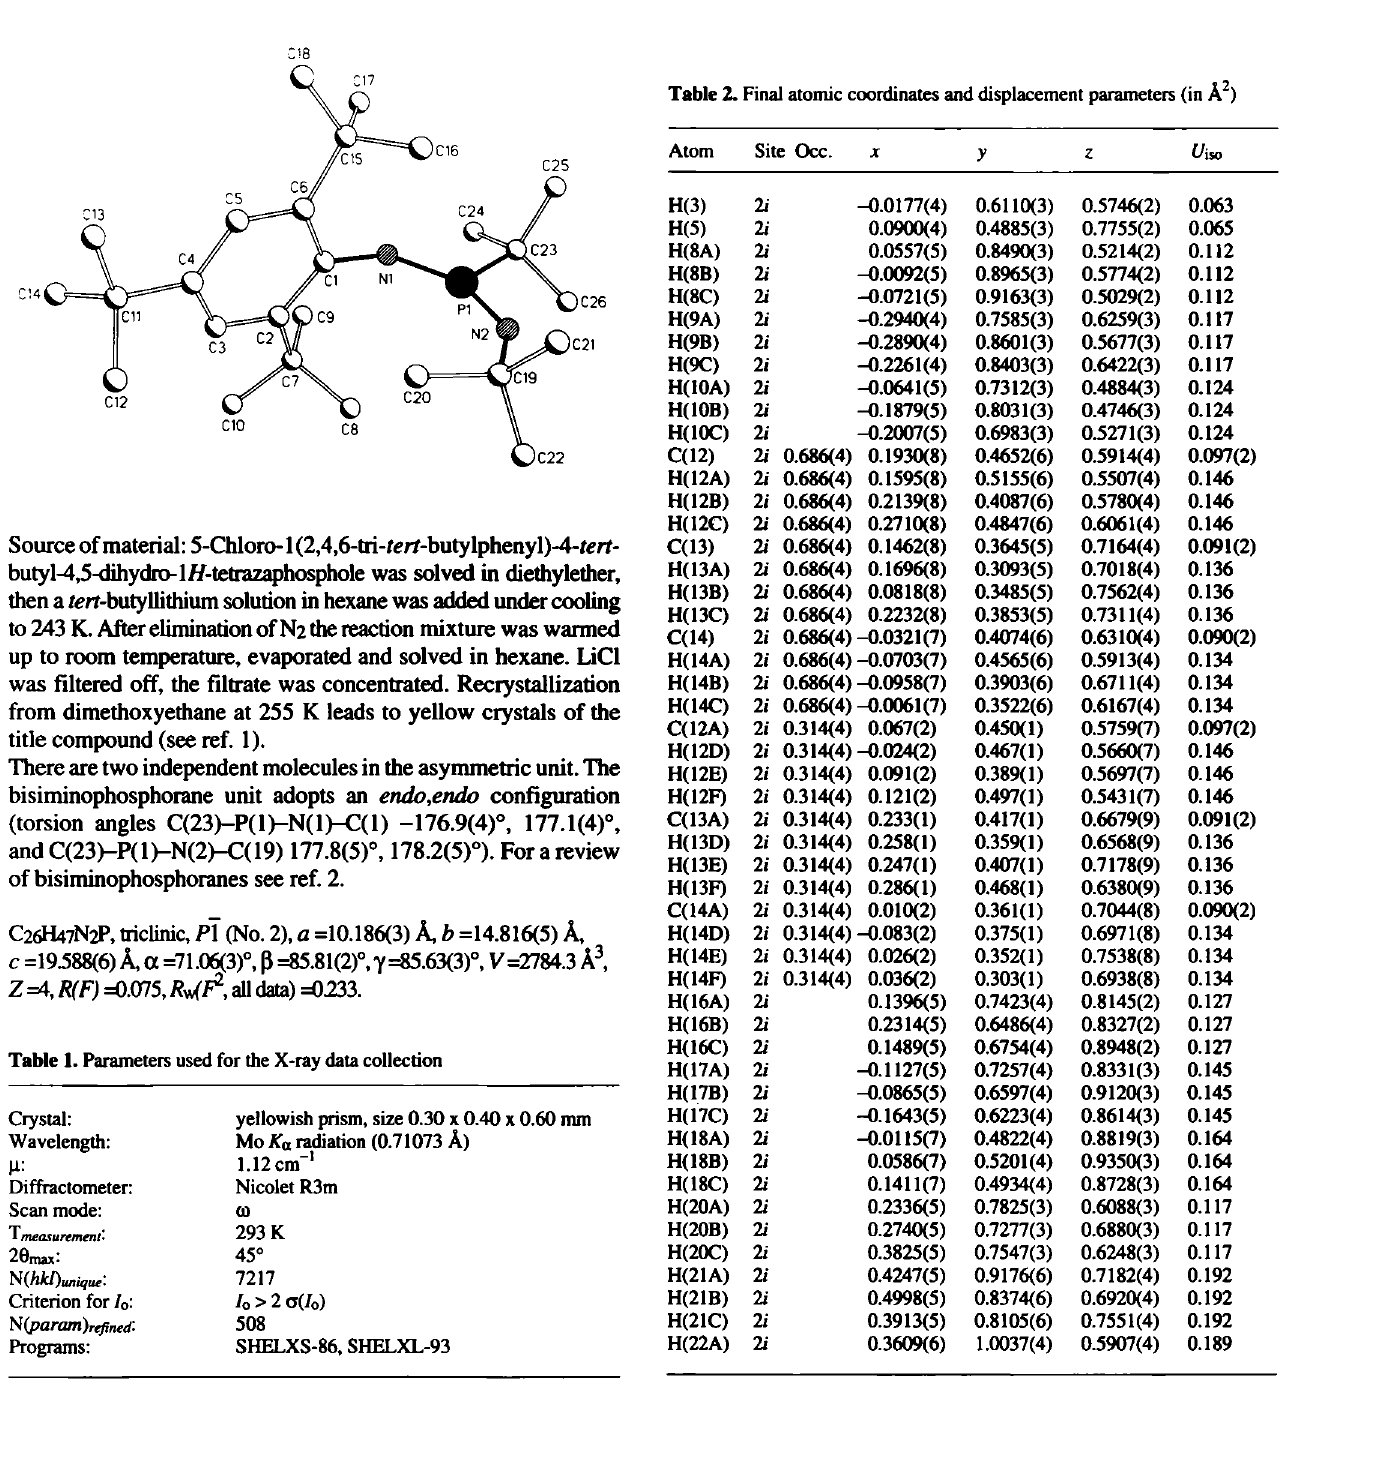
Table 2. Final atomic coordinates and displacement parameters (in Â 2 )